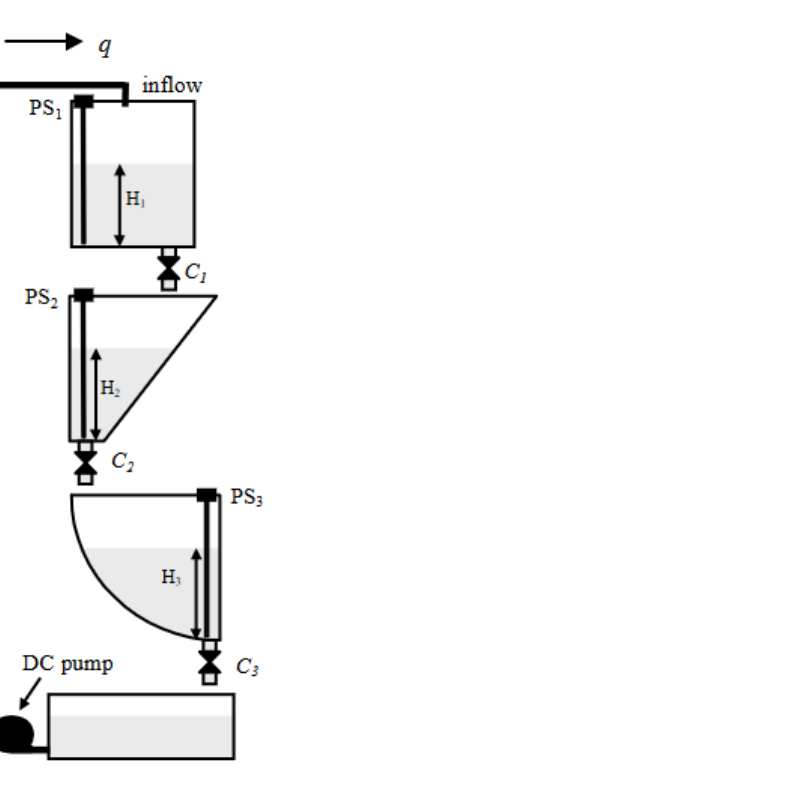
Figure 1. The arrangement scheme of cascade multi-tank system [46].